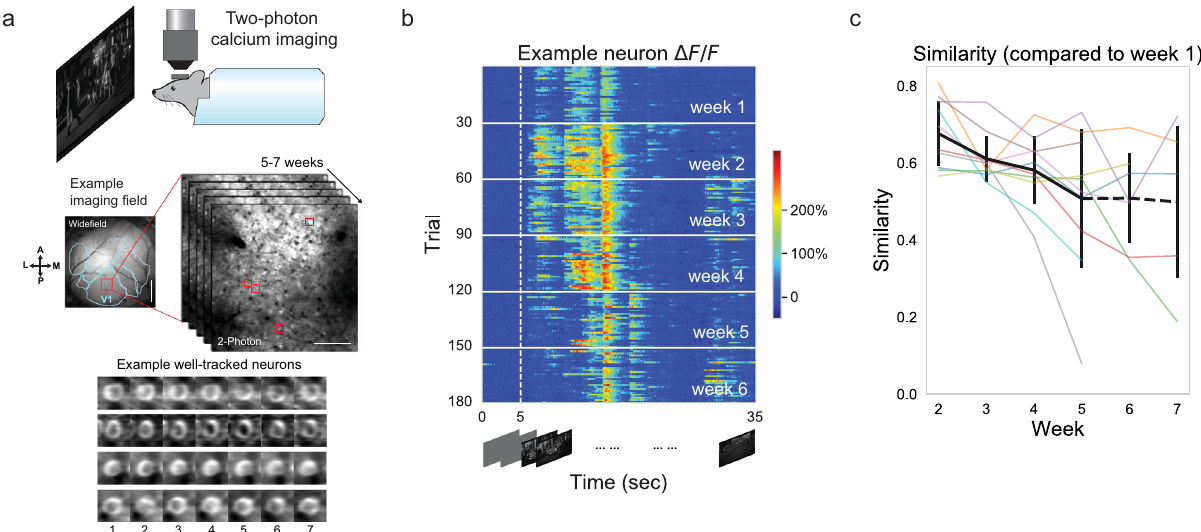
Fig. 1 Single neuron responses to natural movies are unstable across weeks. a Experimental setup. We performed chronic calcium imaging of excitatory neurons in the primary visual cortex of awake, head- fi xed mice during visual stimulation with repeated natural movies. The visual cortex (contralateral to visual stimulus delivery) is retinotopically mapped in Emx1-Cre::TITL-GCaMP6s mice. V1 fi elds are chosen from the region selective for the center of the presentation screen. Wide fi eld scale bar = 1 mm; two-photon scale bar = 100 μ m. The average activity of four example well-tracked neurons across weeks are shown in the bottom panel. b Δ F / F responses of one example neuron during the same natural movie clip for 30 trials per experimental session for 6 weeks (movie starts at 5 s and lasts for 30 s duration). We recorded one experimental session per week. c Similarity (correlation coef fi cient between trial-averaged Δ F / F ) averaged over neurons during week 1 and that during other weeks are plotted for all the recorded imaging fi elds. Different imaging fi elds are denoted by different colors. The black curve with the error bar denotes the mean and standard deviation of similarity over imaging fi elds. Ten imaging fi elds have recordings for weeks 1 − 5. Only a subset of imaging fi elds has recordings on week 6 (seven fi elds) and week 7 ( fi ve fi elds). Speci fi cally, the similarities of the fi fth week were signi fi cantly lower than the similarities of the second week (one-sided Wilcoxon signed-rank test, p = 0.0035, ten imaging fi